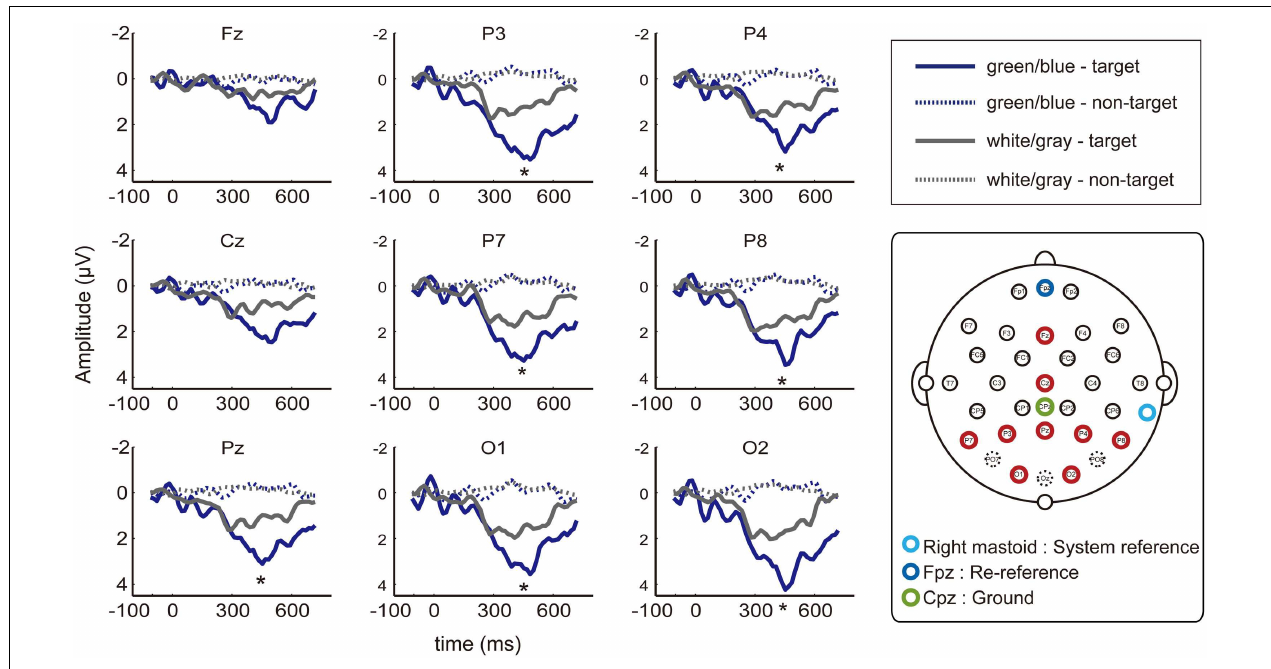
target.The green/blue or white/gray condition is shown in blue or gray, respectively. Asterisks indicate significantly larger amplitudes under the green/blue condition than under the white/gray condition (P7, P3, Pz, P4, P8, O1, and O2; p < 0.05, paired t